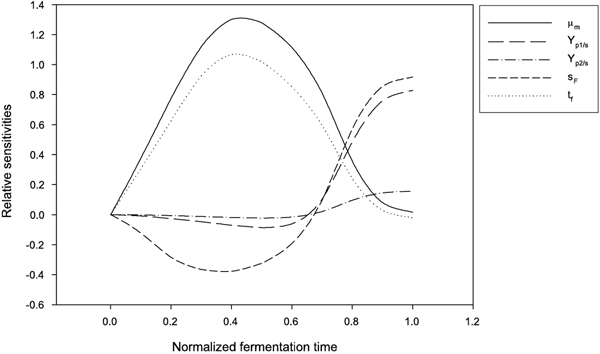
Dynamic relative sensitivities of J. The relative sensitivities of ethanol production rate with respect to μ
m
, 



Y


p
1

/
s




, 



Y


p
2

/
s




, s
F
, and t
f
. The horizontal scale is in normalized fermentation time (t/t
f
).